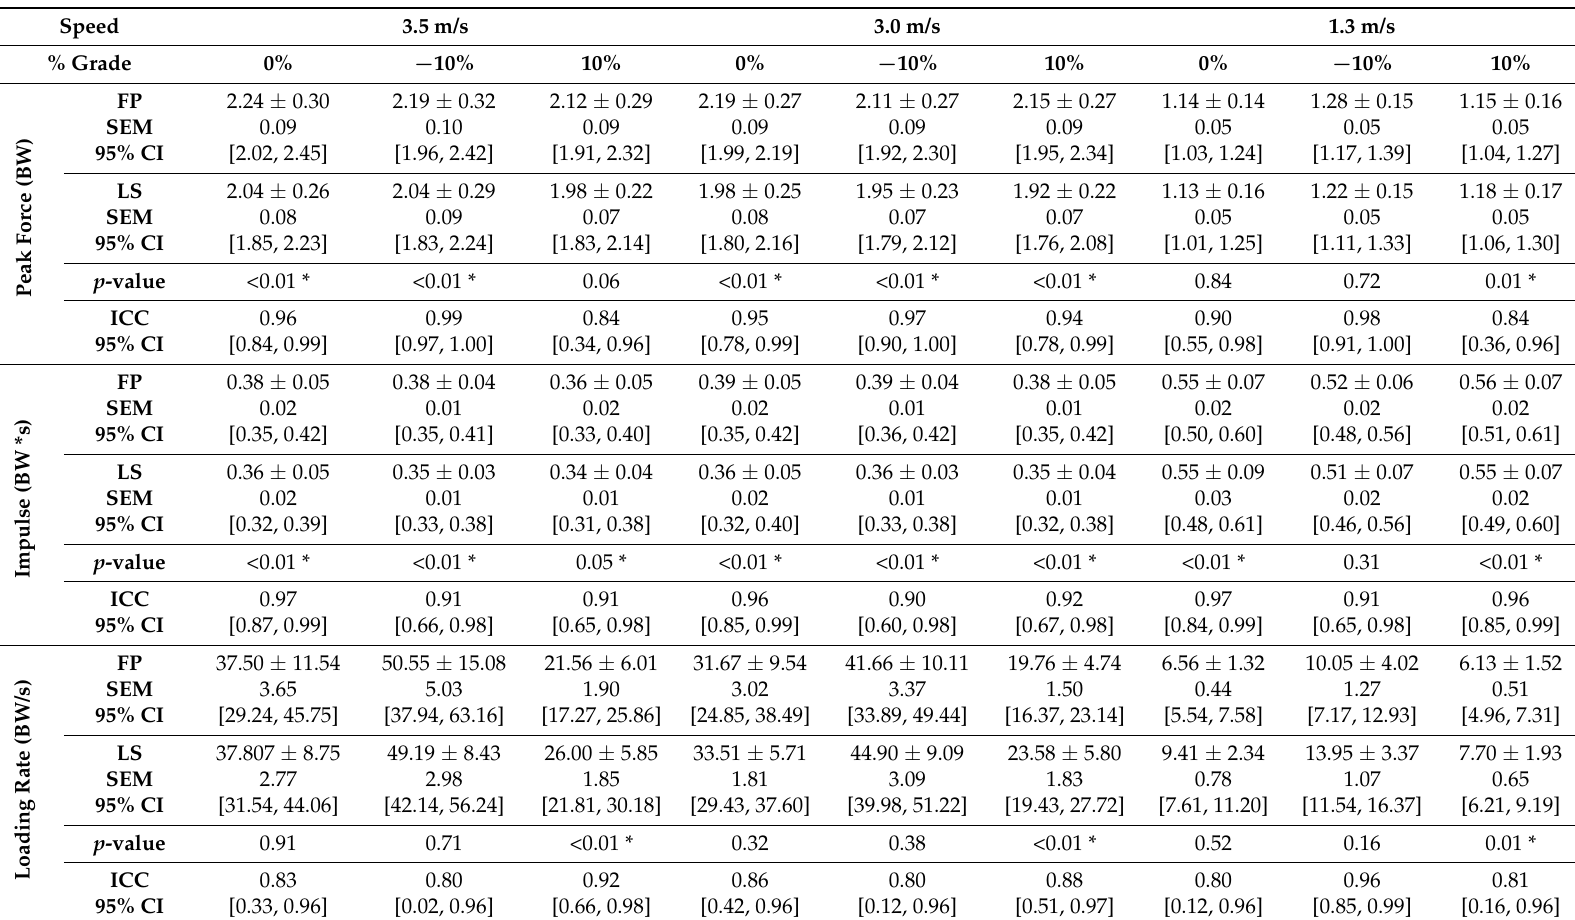
Table 3. Peak force, impulse, and loading rate (LR) results for the force plate (FP) and loadsol ® (LS) results of the 200 Hz loadsol ®